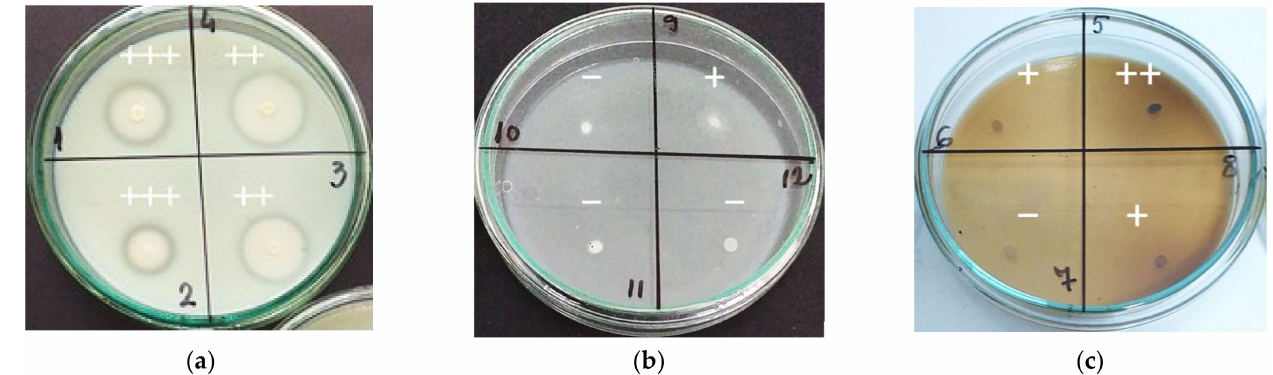
Figure 5. Extracellular enzymes production of indigenous lactic acid bacteria strains (3–5 days, 30 ◦ C). ( a ) Protease activity (a clear halo around the colonies indicates positive reaction); ( b ) Esterase activity (an opaque halo around the colonies indicates positive reaction); ( c ) β -glucosidase activity (a brown halo around the colonies indicates positive reaction); − , +, ++, +++ indicates no activity, low, average and high enzymatic activity, respectively.